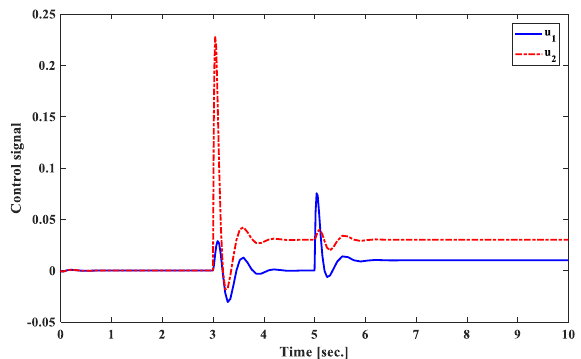
Figure 3. Tie line power deviation [p.u.MW] with matched disturbances.